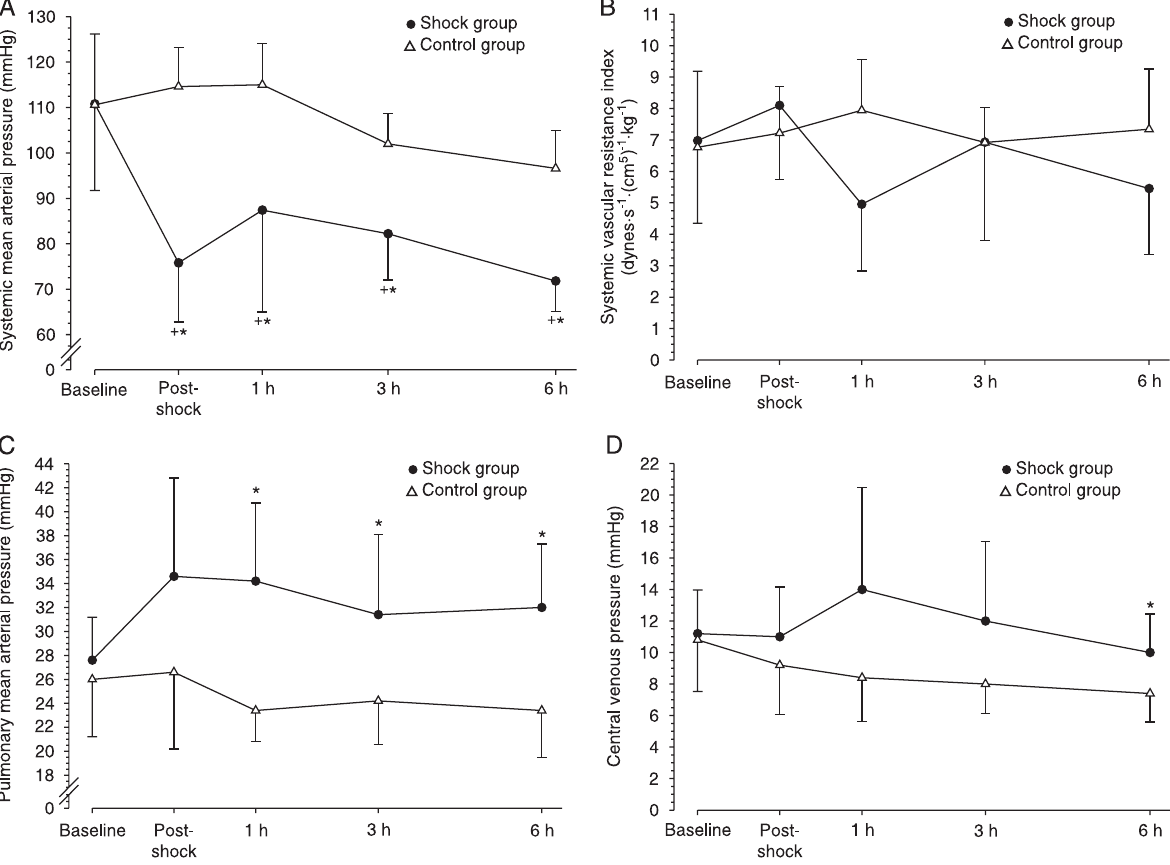
Figure 2. Systemic hemodynamic and perfusional features of pigs during the study. Filled circles = shock group; open triangles = control group. Panel A, systemic mean arterial pressure over time (two-way ANOVA: P < 0.001, between analysis; P < 0.001, within analysis and P = 0.029, factor x time interaction). Panel B, systemic vascular resistance index during the study (two-way ANOVA: P = 0.223, between analysis; P = 0.700, within analysis and P = 0.252, factor x time interaction). Panel C, pulmonary mean arterial pressure over time (two-way ANOVA: P < 0.001, between analysis; P = 0.589, within analysis and P = 0.422, factor x time interaction). Panel D, central venous pressure (two-way ANOVA: P = 0.007, between analysis; P = 0.545, within analysis and P = 0.536, factor x time interaction). Data are reported as means ± SD for 5 pigs in each group. *P < 0.05 vs control group (Tukey post hoc analysis). + P < 0.05 vs baseline (Tukey post hoc